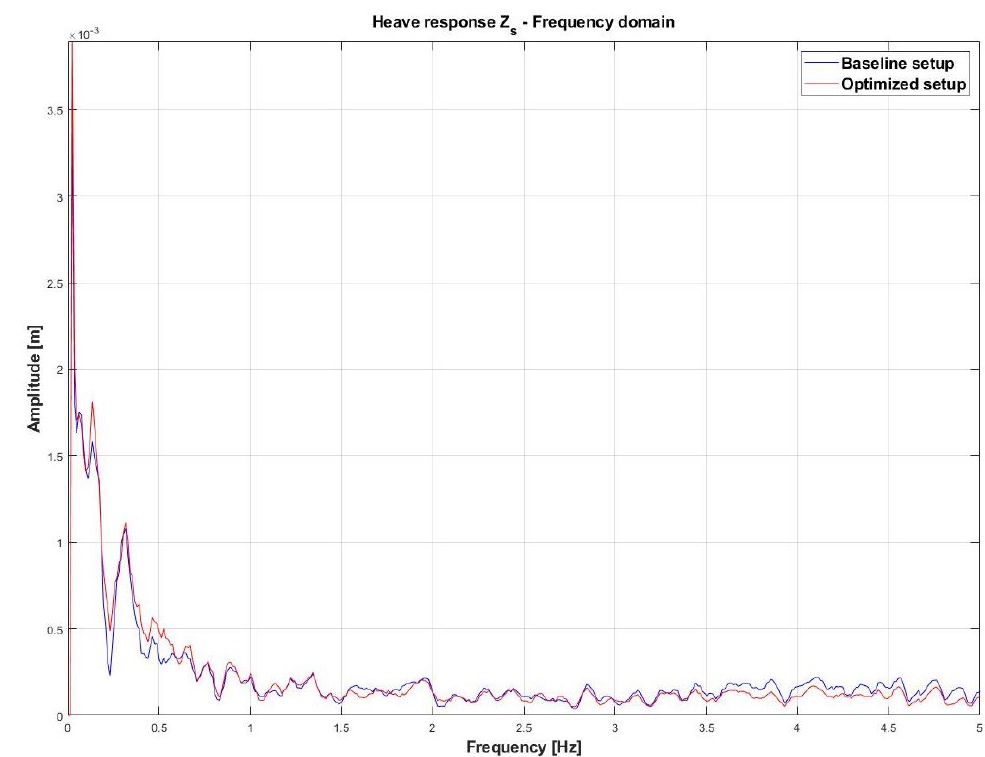
Figure 25. Comparison between the baseline provided setup and improved setup for the heave response of the car in the frequency domain.